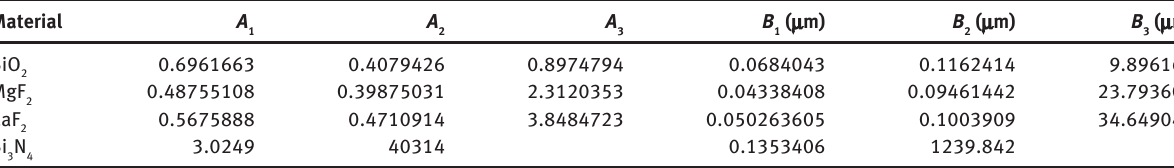
Table 1: Coefficients of Sellmeier equations in microresonator material [43].